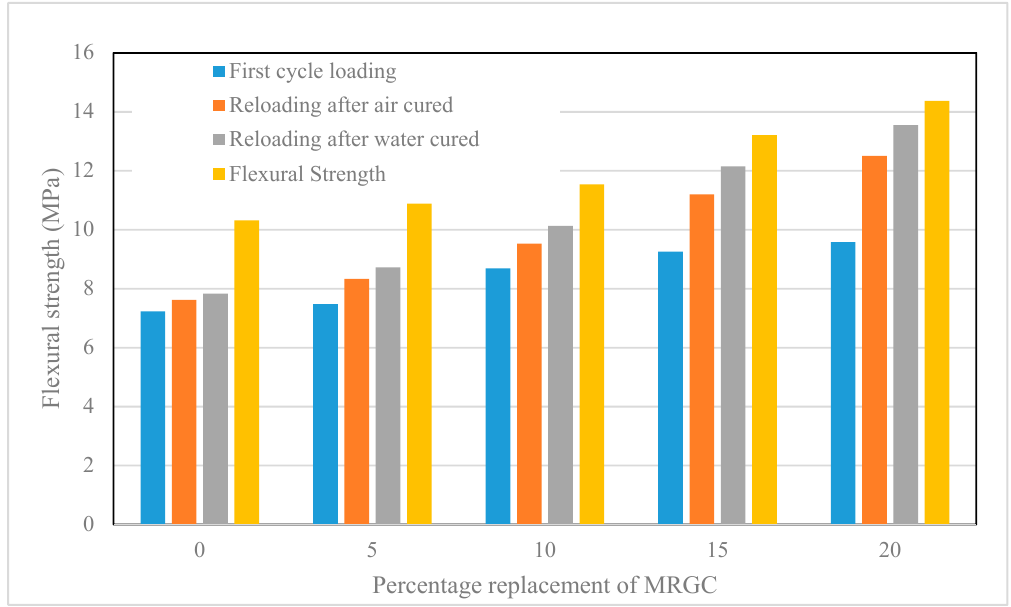
Figure 5. Flexural strength regained due to the crack healing effect of MRGC.